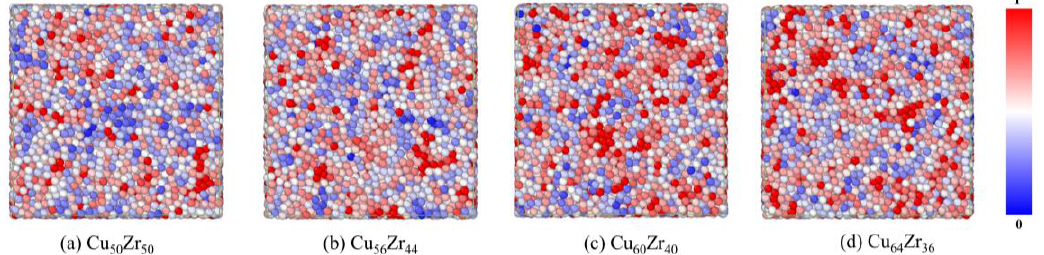
Figure 5. Local five times symmetry distribution of different component amorphous alloys, with the color red representing atoms with high LFFS and the color blue representing atoms with low LFFS.